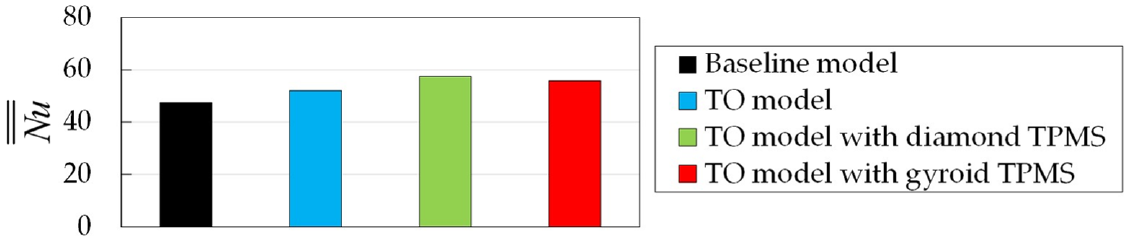
Figure 15. Globally averaged Nusselt numbers for all serpentine channels at Re = 10,000. The total Nusselt number (